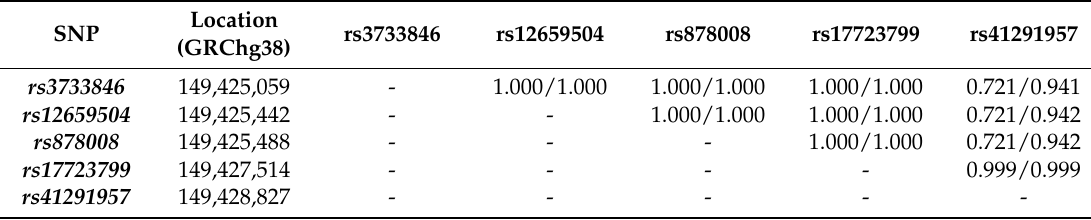
Table 7. Linkage disequilibrium (D’) values for SNPs on chromosome 5 in HapMap 1000G European (EUR) Central European (CEU)/Great Britain (GBR)